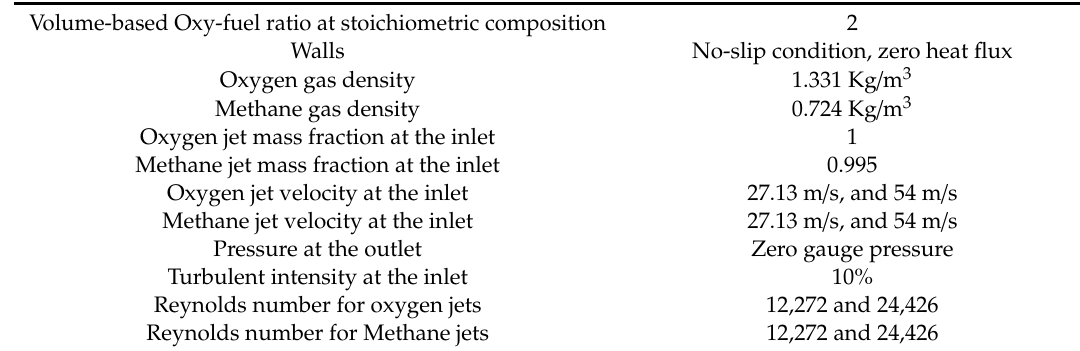
Table 1. Boundary